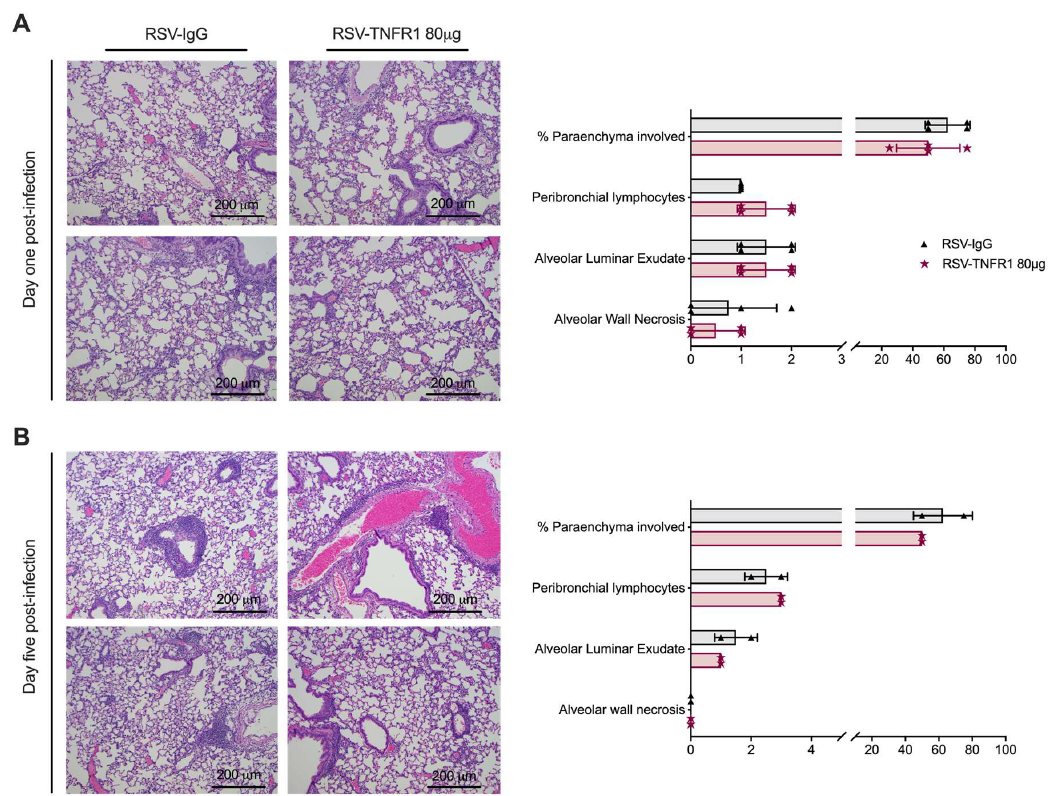
Figure 5. Blockade of TNFR1 at the dose of with 80 µ g does not a ff ect lung pathology in RSV infections. Lung tissue was collected at days ( A ) one and ( B ) five p.i., embedded in para ffi n for sectioning and slides were stained with H&E. Pathology scores for each set are shown to the right of the lung images. Data are expressed as mean ±